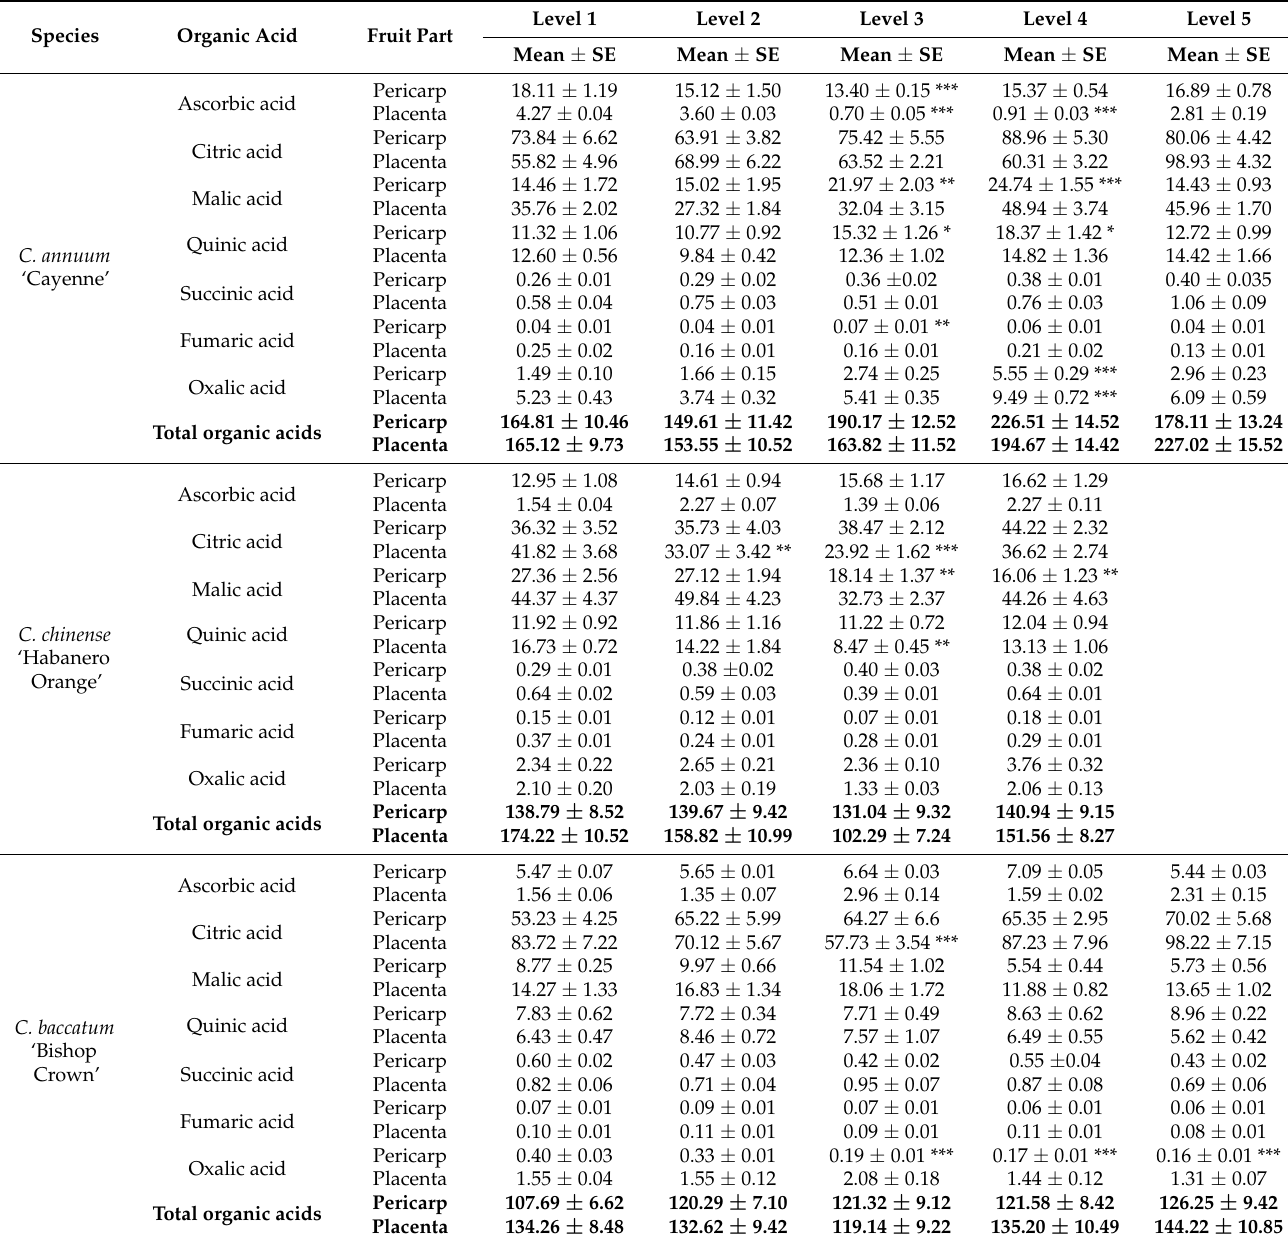
Table 3. Individual and total organic acids content (g/kg DW, mean ± SE) in different species and two different fruit